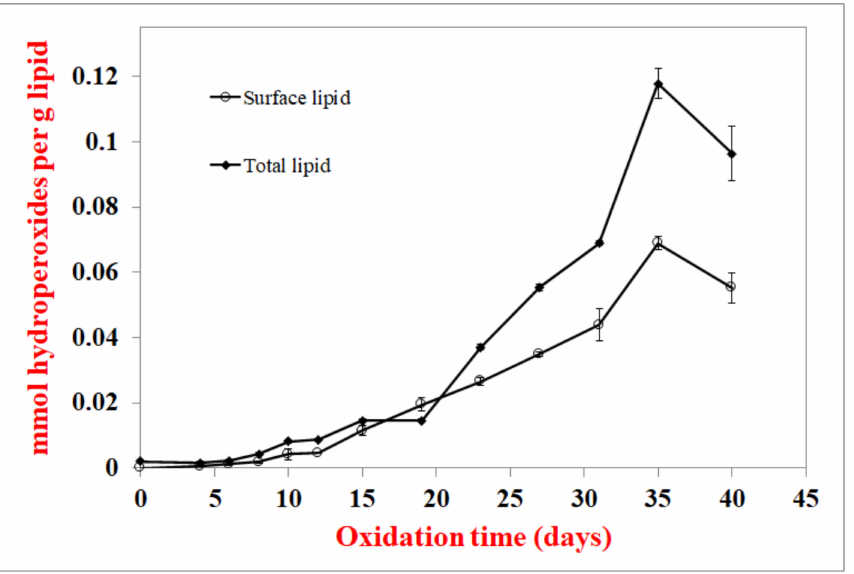
Figure 2. Surface oil vs. total lipid hydroperoxide formation at 55 ◦ C. Data points are the average of 3 measurements ± standard